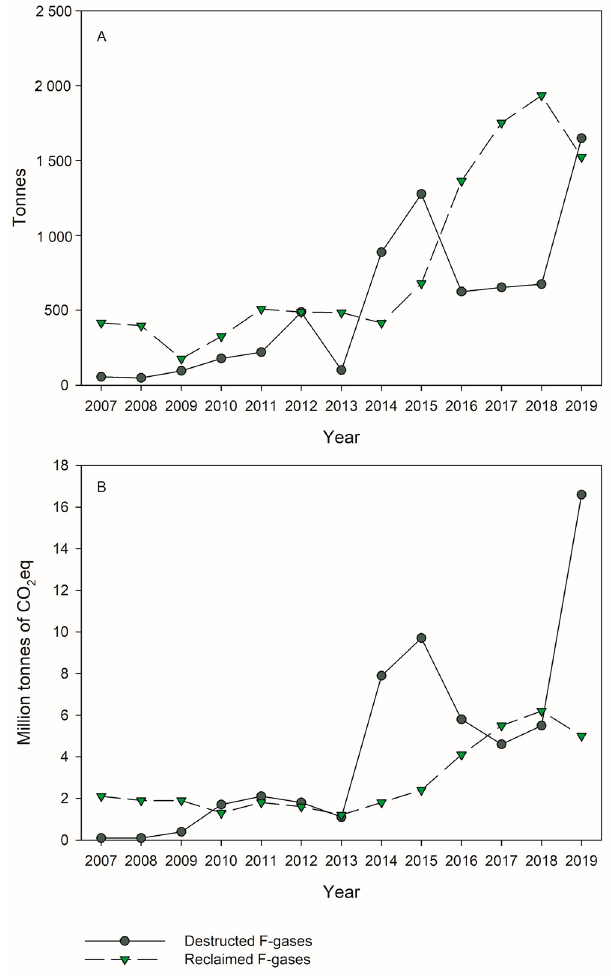
Figure 3. Destruction and Reclamation of F-gases in the EU (2007–2019) according to the EEA Report No 15/2020 on fluorinated greenhouse gases [25]. Data in tonnes of gas (Panel ( A )) and in million tonnes of CO 2 eq (Panel ( B )).